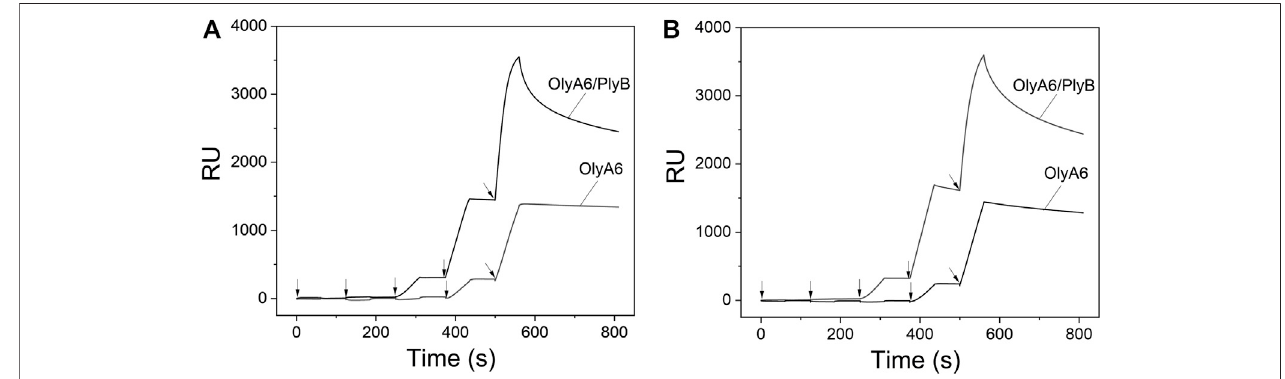
FIGURE 4 | Binding of OlyA6 and OlyA6/PlyB (12.5/1, molar ratio) to immobilized equimolar CAEP/POPC/Chol (A) and CPE/POPC/Chol (B) large unilamellar vesiclesusingthekinetictitrationapproachinasinglecyclebysuccessiveinjectionsof0.03,0.06,0.12,0,25,and0.5 μ M(fromlefttoright)concentration.Vesicleswere immobilized on the Biacore L1 chip to approximately 8,000 response units (RU). Representative sensorgrams from two independent experiments are shown. CPE- ceramide phosphoethanolamine, Chol-cholesterol, POPC-1-palmitoyl-2-oleoyl- sn -glycero-3-phosphocholine, CAEP-ceramide aminoethylphosphonate.